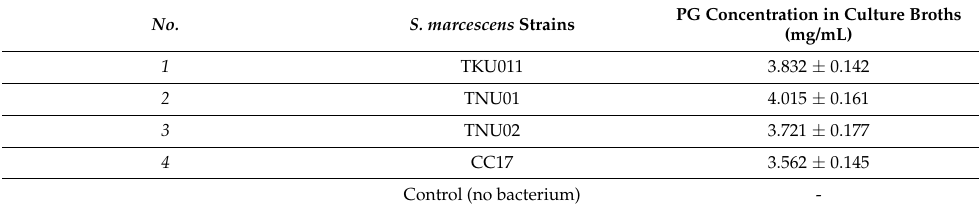
Table 1. PG production by different S. marcescens